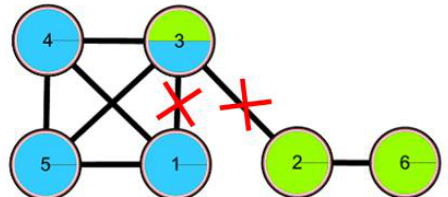
Figure 3. An example of a CES result. Figure 4. An example of the first pruning strategy. Figure 4. An example of the first pruning strategy.